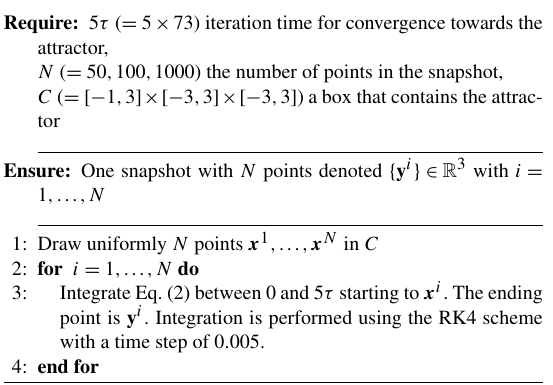
Algorithm 1 Simulation of a snapshot attractor with N initial conditions from the Lorenz 84